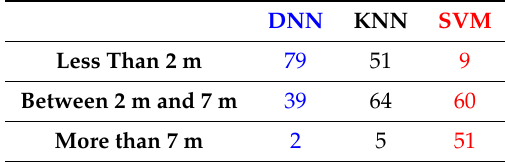
Table 4. Frequency Count of Distance error (m) for each